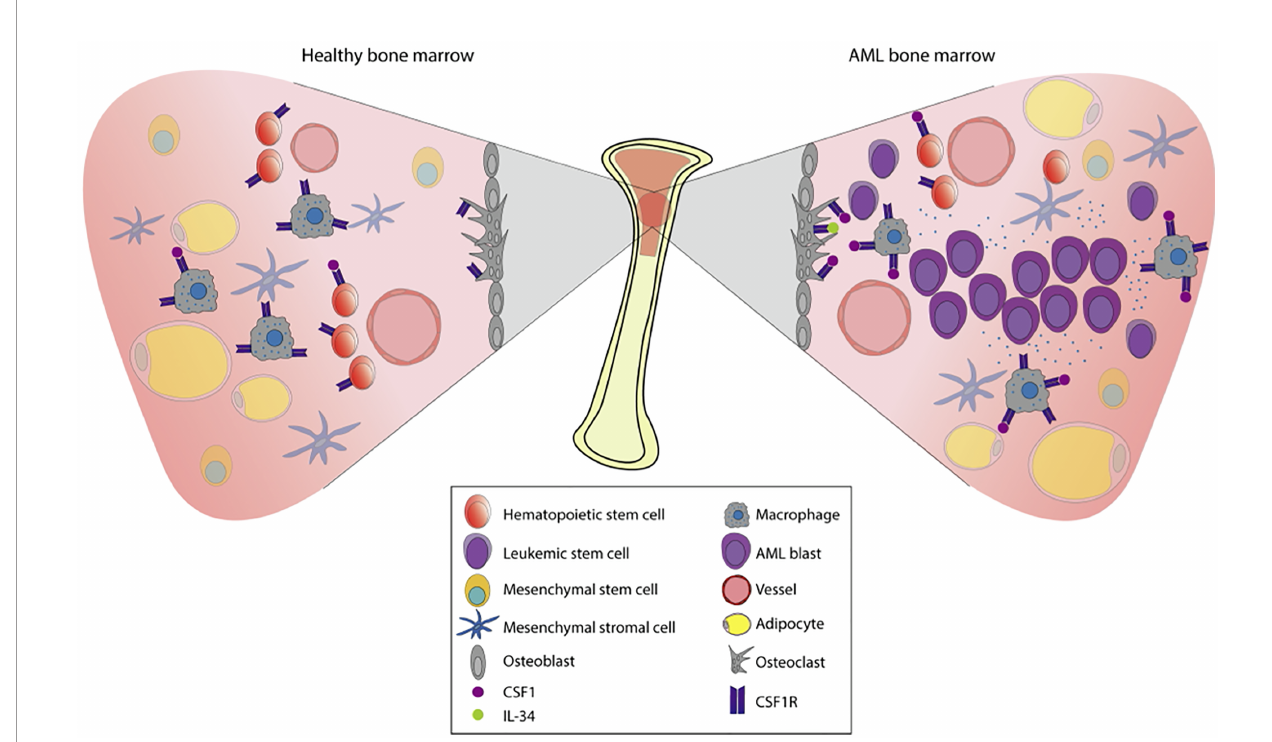
FIGURE 3 | Pathophysiology of AML in the bone marrow. The bone marrow is a tissue organized to protect cell proliferation. Under normal conditions (left), the multipotent hematopoietic stem cells (HSCs) will give rise to the myeloid and the lymphoid lineages. Myeloid lineage transcription factors regulate the expression of CSF1R, already present in macrophage precursors. The stromal environment is composed by osteoblasts, osteoclasts, adipocytes, macrophages, mesenchymal cells, and vessels that will allow this differentiation process to take place. When there is a dysregulation of proliferation and apoptosis in myeloid precursors, hematologic malignancies such as AML may appear. In AML (right), proliferation and survival rely on the bone marrow stromal cells signals. These signals are strongly mediated by the CSF1R which is expressed in certain cell types (shown in the fi gure), contributing to paracrine